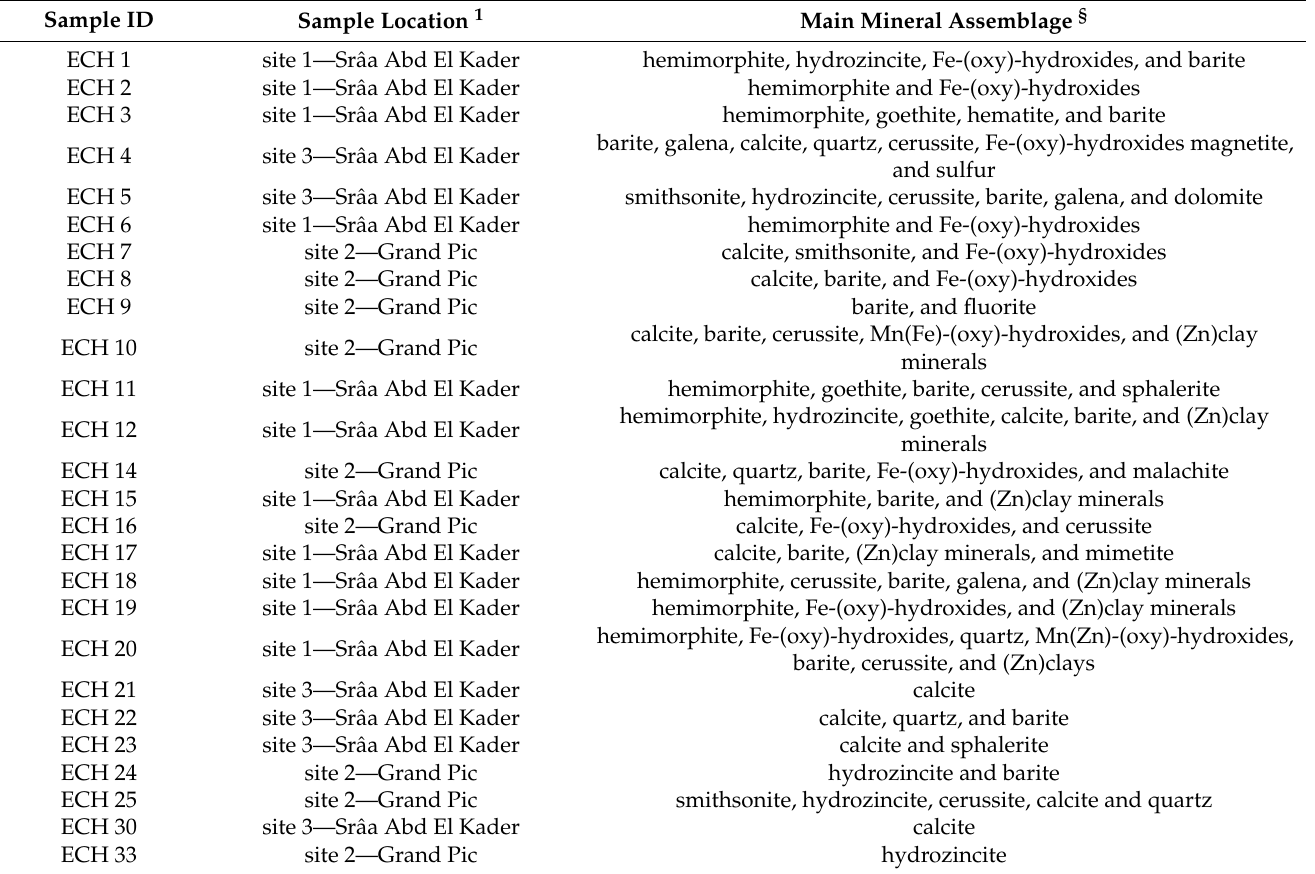
Table 1. Origin and mineral assemblages of studied samples inferred by PXRD and SEM-EDS